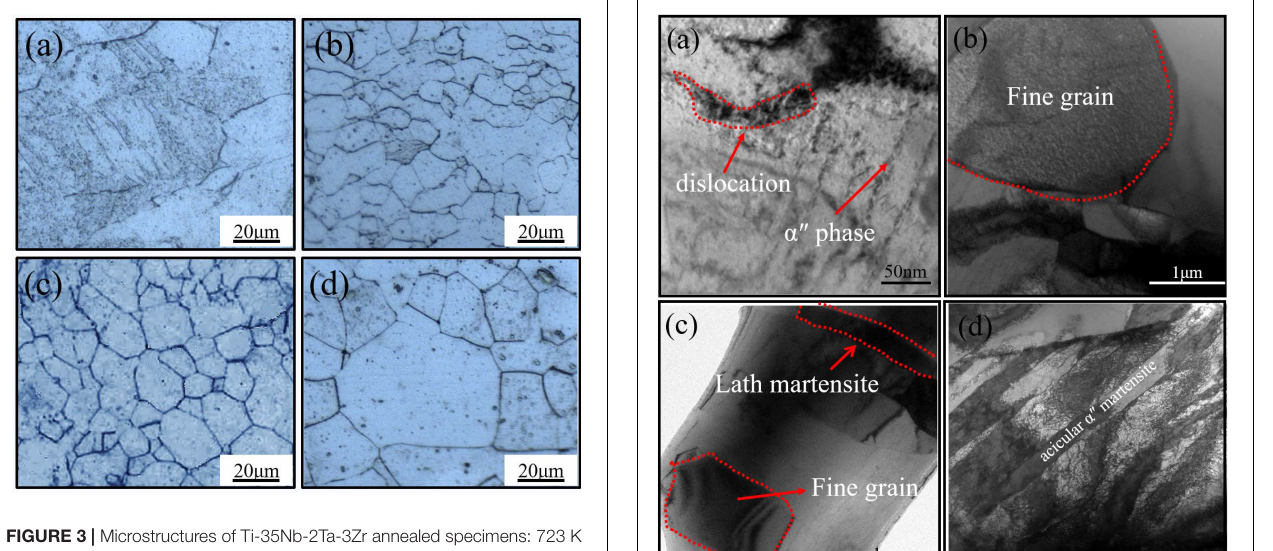
FIGURE 3 | Microstructures of Ti-35Nb-2Ta-3Zr annealed specimens: 723 K (a) , 823 K (b) , 923 K (c) , and 1023 K (d) .